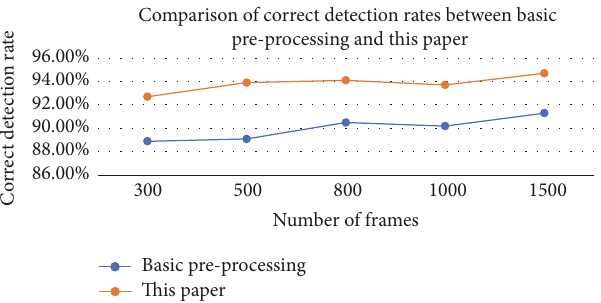
Figure 20: Comparison of correct detection rates between basic preprocessing and this paper.